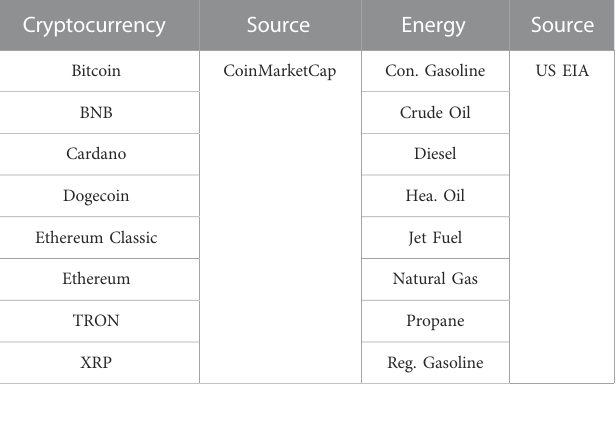
TABLE A1 Choice and sources of cryptocurrencies and energies.